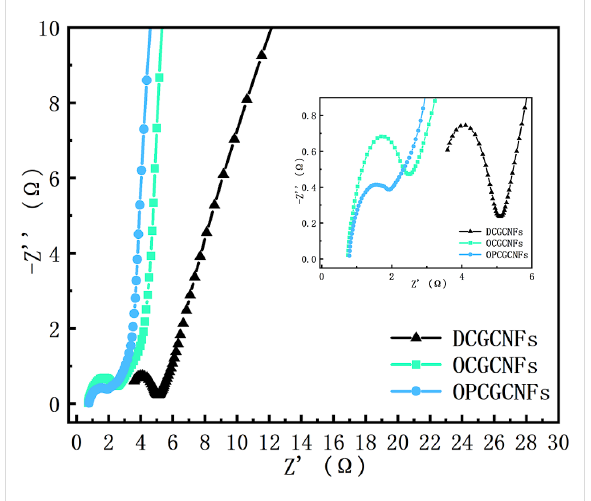
Figure 7: Electrochemical impedance spectra of the samples repre- sented as Nyquist